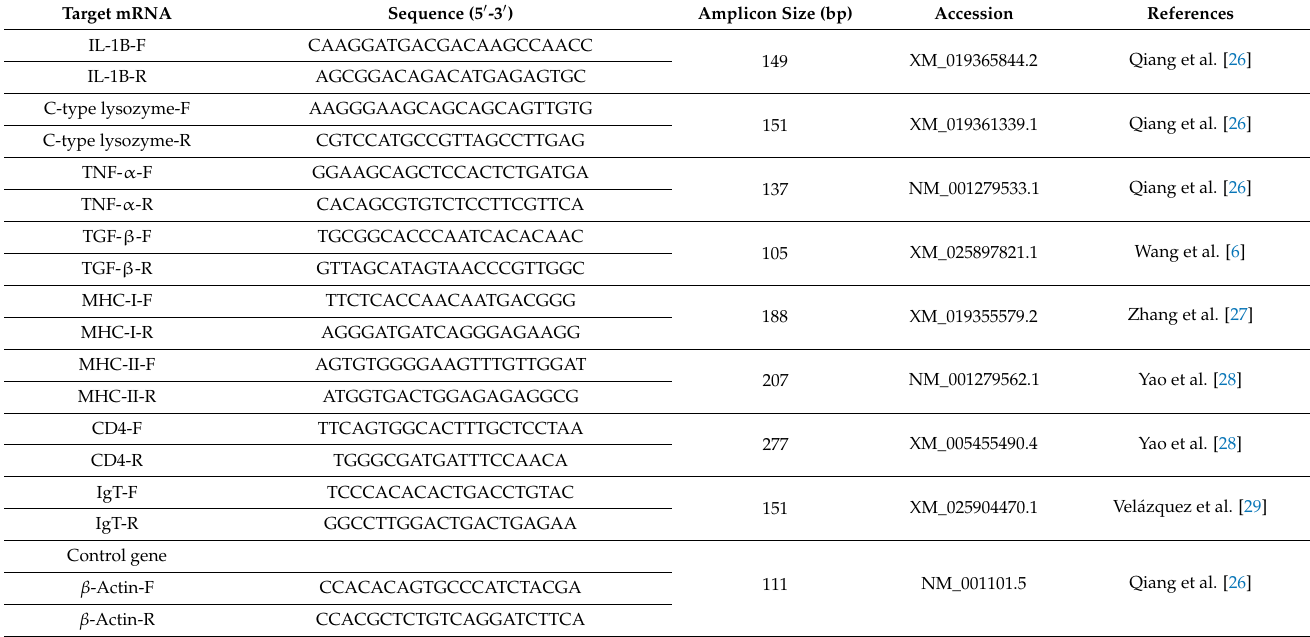
Table 1. Primers for gene expression in red hybrid tilapia by real-time PCR, with expected amplicon size and original